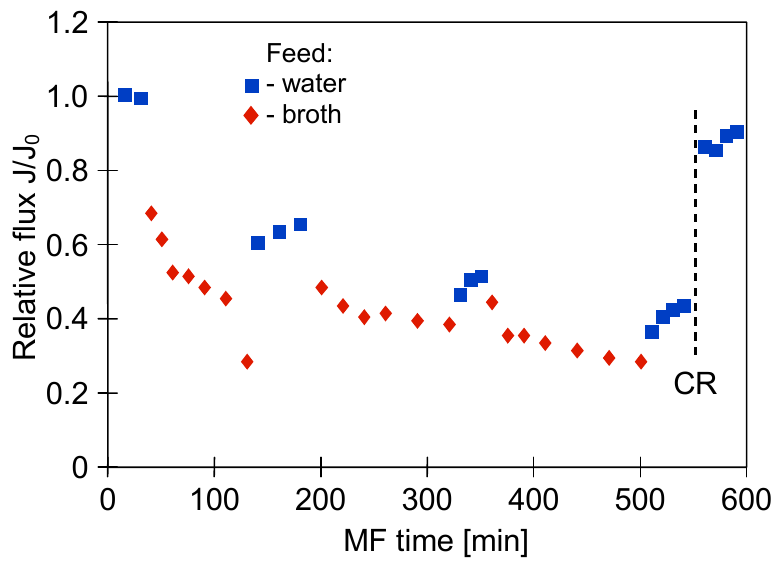
Figure 4. Changes in relative permeate flux during microfiltration (MF) of 1,3-propanediol (1,3- PD) fermentation broth with Citrobacter freundii . Module M1, TMP = 0.03 MPa, V F = 0.8 m/s, CR—chemical cleaning (1% NaOH).